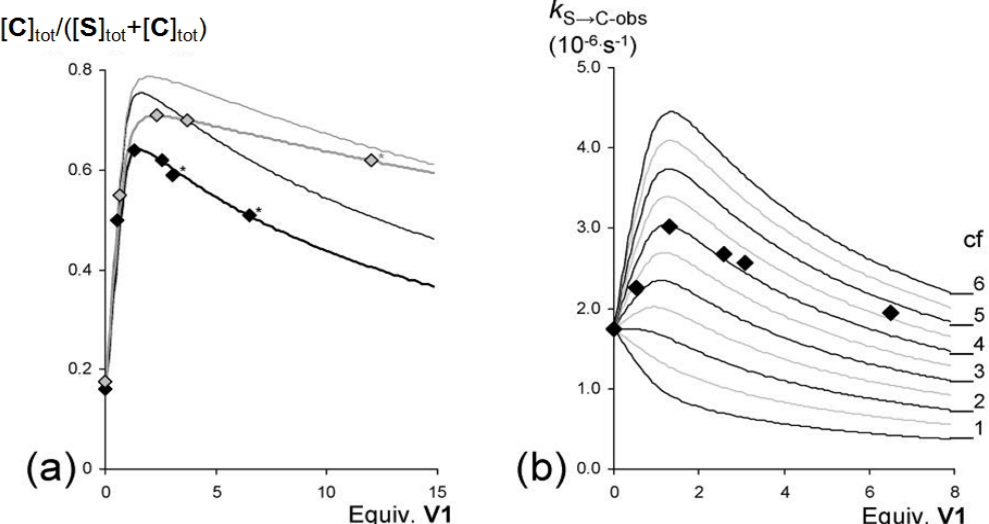
) and equilibrium constants ( K S → C-obs